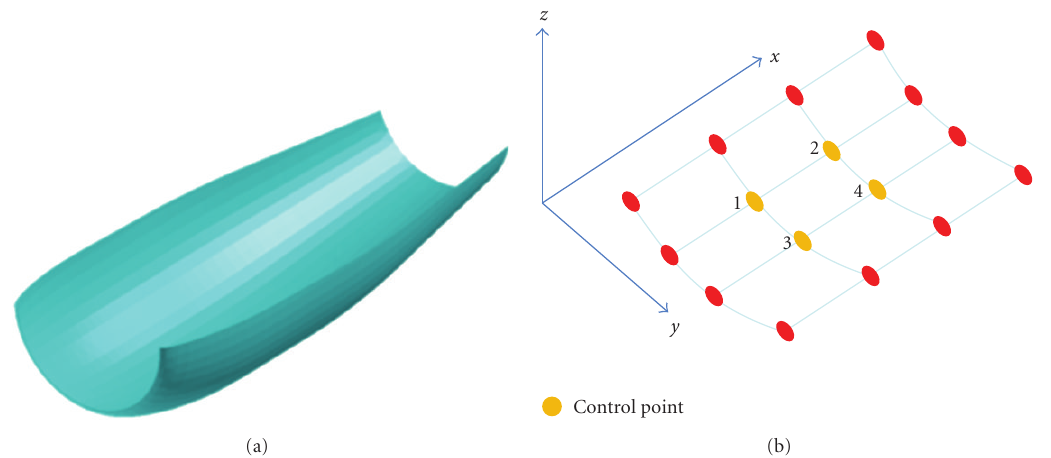
Figure 5: Nacelle lower shape definition.